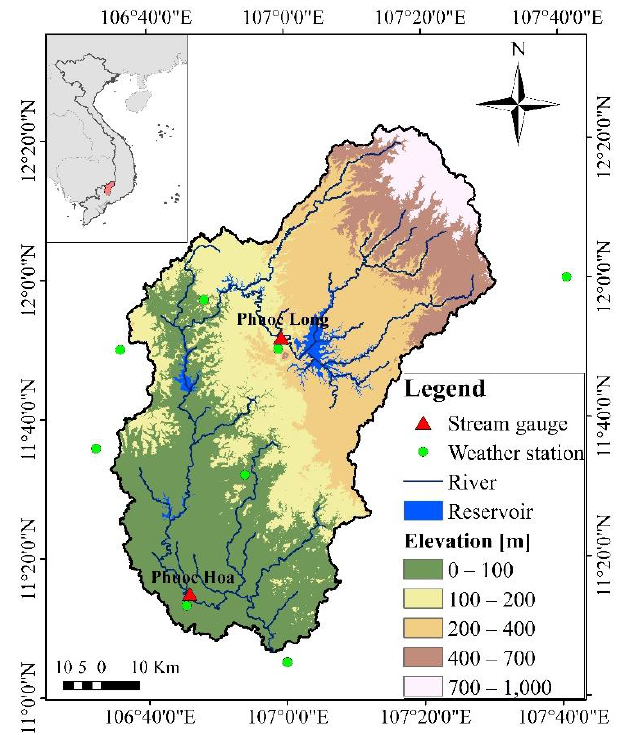
Figure 1. Map of the study area.